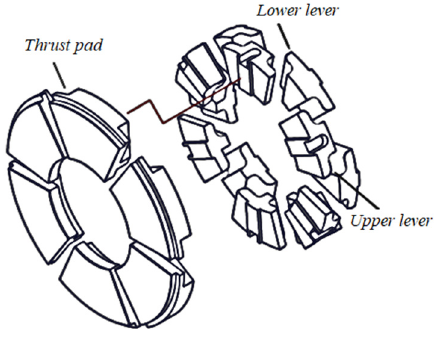
Figure 1. Support structure of the Kingsbury thrust bearing.